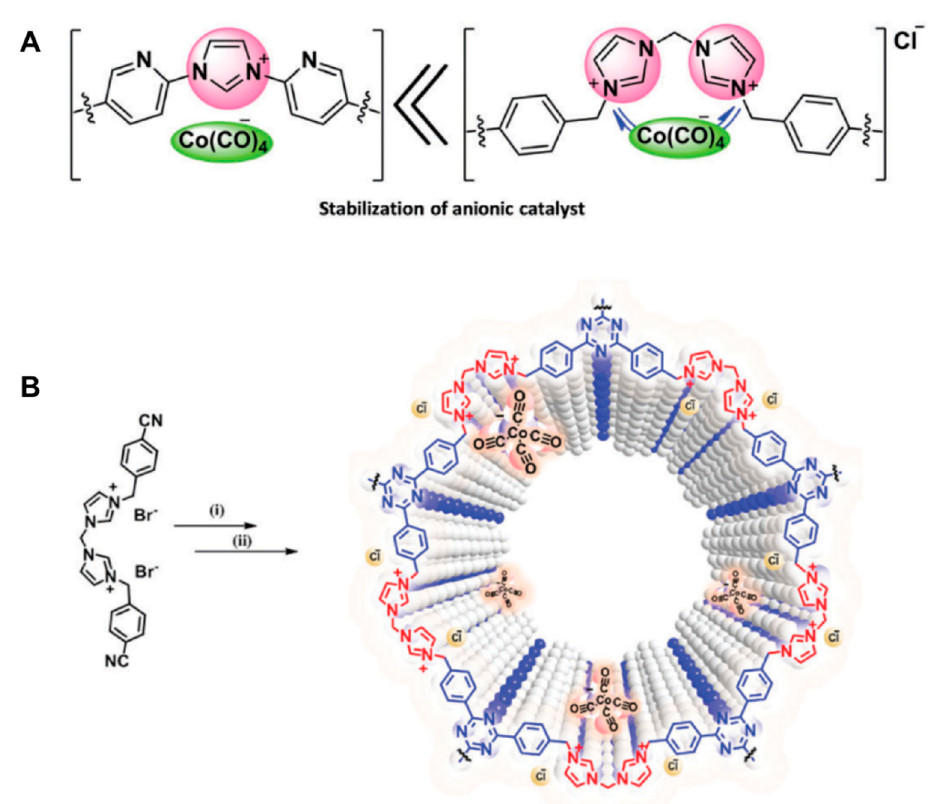
Figure 9. ( A ) Comparison of the intramolecular stabilization of anion in (bis-imidazolium-CTF-Cl)(Co(CO) 4 ) ( right ) over (imidazolium-CTF)(Co(CO) 4 ) complexes ( left ); ( B ) Representation of the synthesis of (bis-imidazolium-CTF-Cl)(Co(CO) 4 ) (i) ZnCl 2 , 400 °C; 48 h (ii) KCo(CO) 4 , MeOH, 50 °C, 0.5 MPa of CO, 24 h (Adapted with permission from [56]. Copyright 2018, Royal Society of Chemistry).